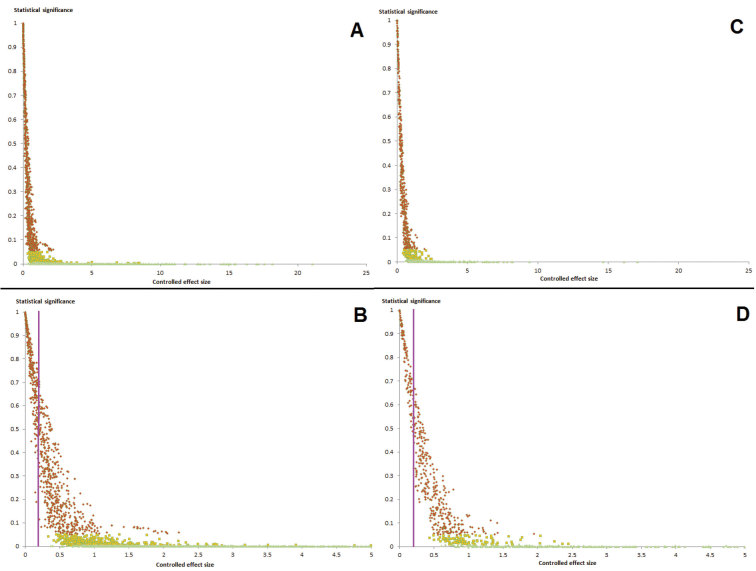
Scatter-graphs of controlled unpooled effect size (x-axis) versus statistical significance (p<x) (y-axis). All outcomes to the right of the two purple lines represent pairwise comparisons which are given scores of at least 1 under the Tobias et al. (2010) system. Note the statistically insignificant outcomes (red rhombuses, to the right of the purple line) which are given scores of 1 under the Tobias et al. (2010) system and the small numbers of such outcomes scoring 2 (two effect sizes or more) and 3 (five effect sizes or more). Figure 4A, B use all 2348 pairwise comparisons for voice. Figure 4C, D show all 822 pairwise comparisons for biometrics. Figure 4B, D are close-ups of Figure 4A, C respectively, showing the area below 5 effect sizes. Red rhombuses represent a lack of statistical significance. Yellow squares represent possible statistical significance, less than p<0.05 but failing tests of significance after applying Bonferroni correction. Green triangles, which are almost continuous along the x-axis, represent statistically significant outcomes. The lower two graphs show greater resolution of the same graphs at effect sizes of up to 5 (where 4 signifies full diagnosis). Note: the graphical representation is generous to Tobias et al. (2010) in applying the most conservative effect size definition from this study on the x-axis; using bare pooled effect sizes as applied by these actions would generally shift outcomes to the right, as illustrated in Figures 2–3.